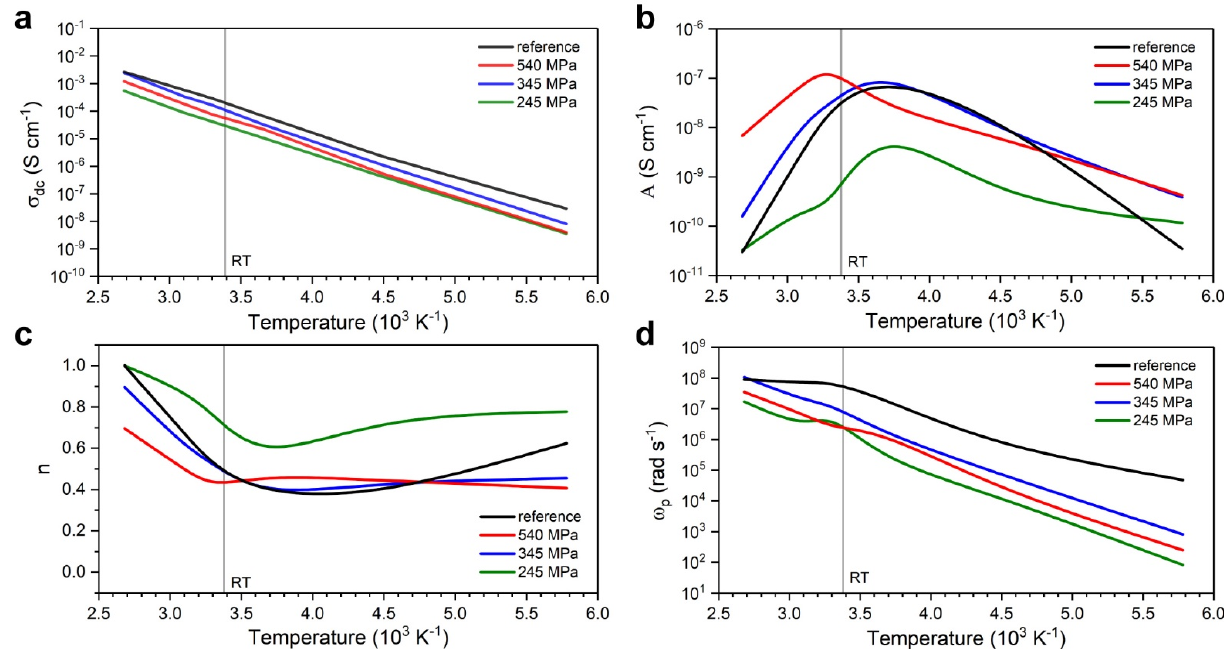
Figure 9. Fitting parameters to the frequency series data according to the Jonscher power law, obtained by the nonlinear Levenberg–Marquardt iteration algorithm and transposed over scaled reciprocal temperature, showing the ( a ) bulk dc electrical conductivity, σ dc ; ( b ) ac conductivity coefficient, A ; ( c ) frequency exponent of the mobile ions, n ; and ( d ) derived crossover frequency, ω p . Parameter fittings correspond to R 2 values ranging from 0.99 to 0.94. Demarcated values correspond to room temperature (RT) conditions.